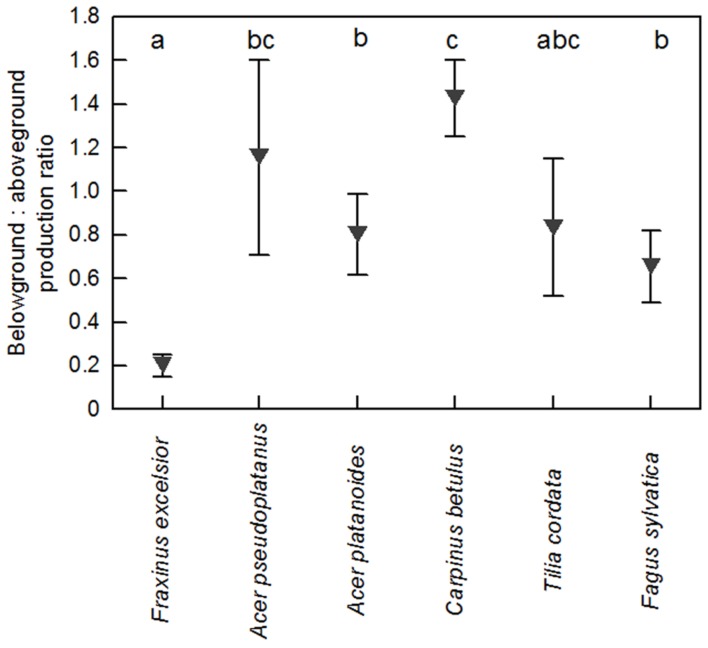
Ratio of annual belowground (fine root) to aboveground (woody biomass) production in the six species. FRP was expressed per m2 ground area; woody biomass production is the growth of the target trees. Statistically significant differences between the species are indicated by different letters.